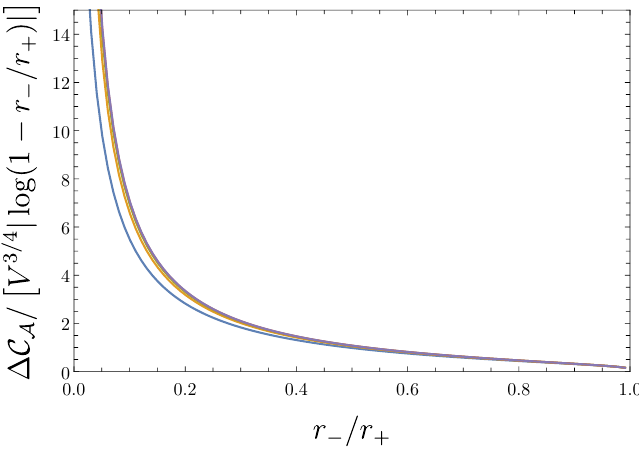
Figure 20. A plot showing the CA complexity of formation normalized by the thermodynamic volume as a function of the ratio r − /r + in five dimensions. The plot shows curves for fixed r + /‘ = 10 , 10 2 , 10 3 , 10 4 , 10 5 , 10 6 and 10 7 , however after r + /‘ = 1000 the curves are visually in- distinguishable. Here we have set ‘ ct = ‘